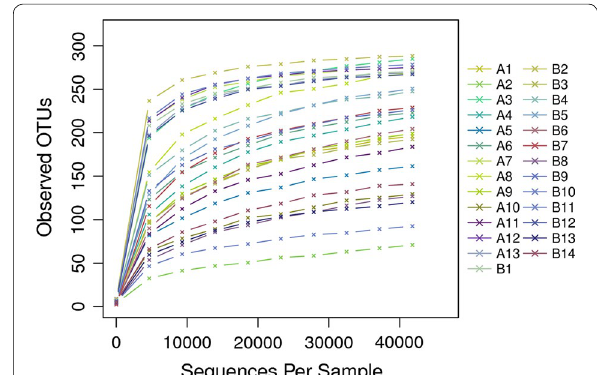
Fig. 2 Rarefaction curve sequences showing the complexities of the microbial communities in the fecal samples of 27 young hens. Samples A1–A13 were collected from hens fed conventional feed supplemented with a crude Astragalus (0.5%) additive, while samples B1–B14 were collected from hens fed conventional feed